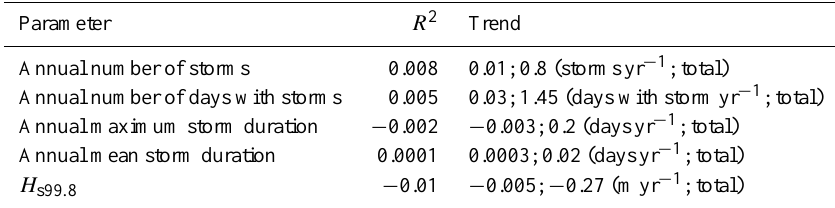
Table 2. Storm parameters and extreme wave height percentile